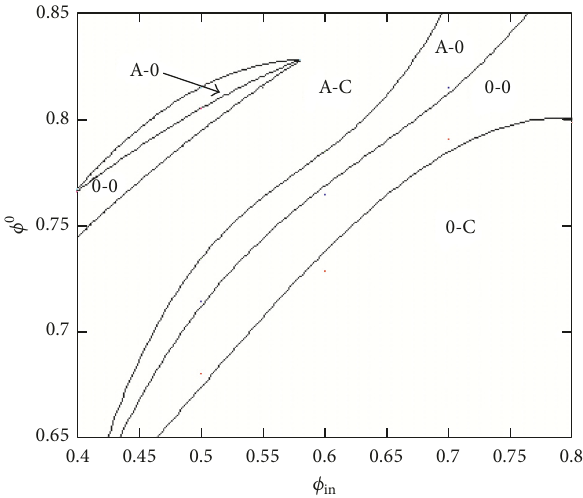
Figure 7: Phase diagram in ( 𝜙 in , 𝜙 0 ) parameter space for scenario B. The corresponding attractors are denoted by their steady state characteristic (0-0, A-C, 0-C or